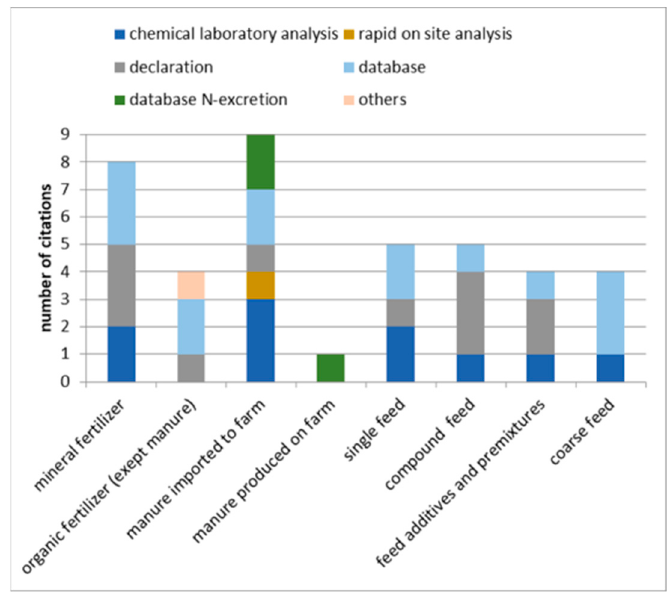
Figure 7. Qualitative determination of elements of nitrogen inflows of farm budgets; multiple answers are possible (Source: expert survey results).